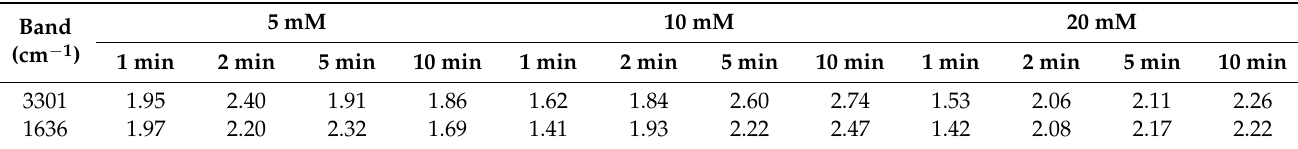
Table 3. Amplification factor obtained from the two bands observed in the pyridine spectrum by FTIR. Band (cm − 1